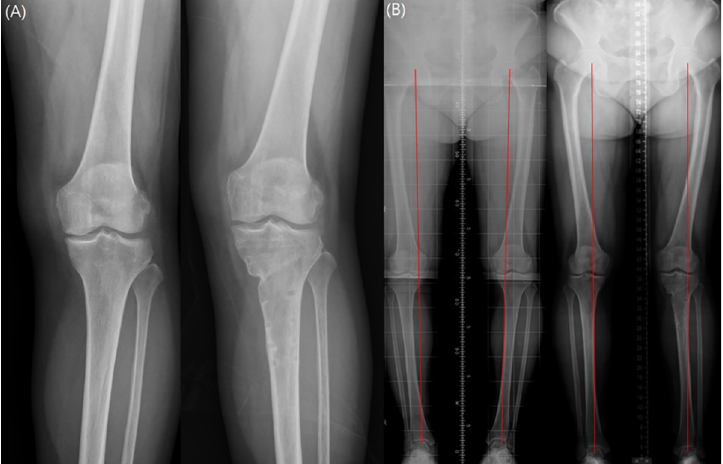
Fig 2. (A) Preoperative (left) and postoperative 2 years (right) standing anteroposterior radiographs of left knee in a 65-year-old female with patient. (B) Preoperative (left) lower extremity orthogram showed 6˚ varus of left lower limb and postoperative 2 years (right) radiograph showed 3.5˚ valgus of left lower limb